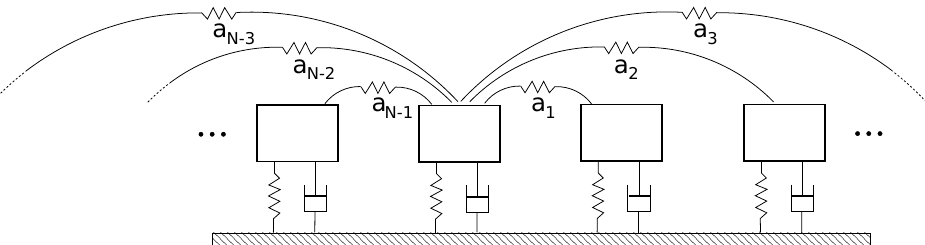
Figure 1. Sketch of the lumped system (recall that a j = a N − j )